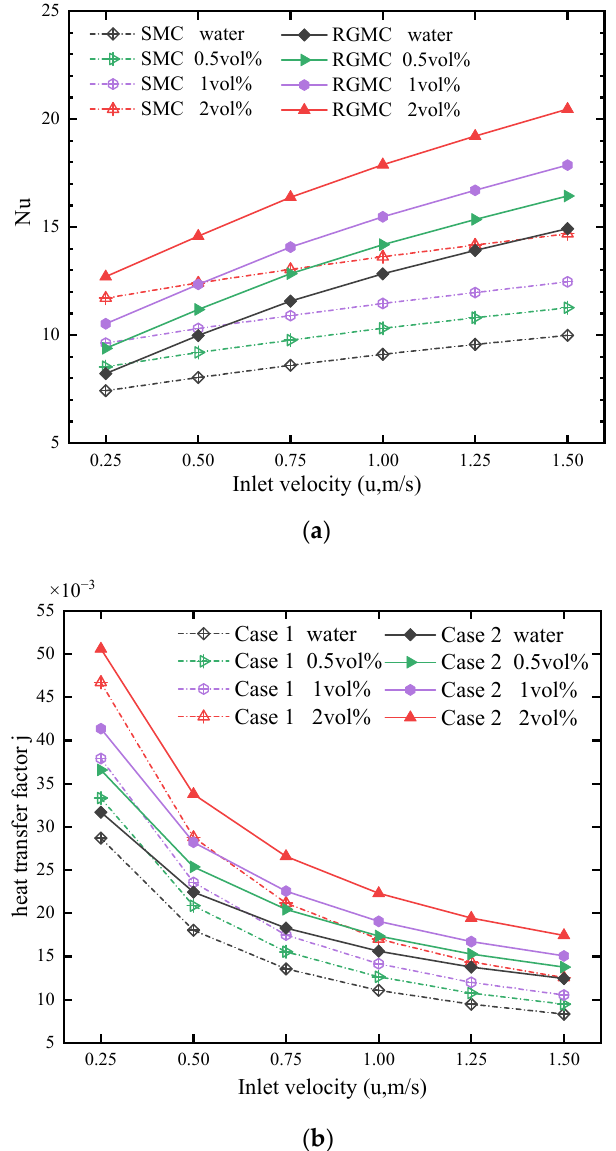
Figure 7. Heat transfer properties of two microchannels with different volume fraction nanofluid and inlet velocity. ( a ) Average Nusselt number. ( b ) The heat transfer factor j.